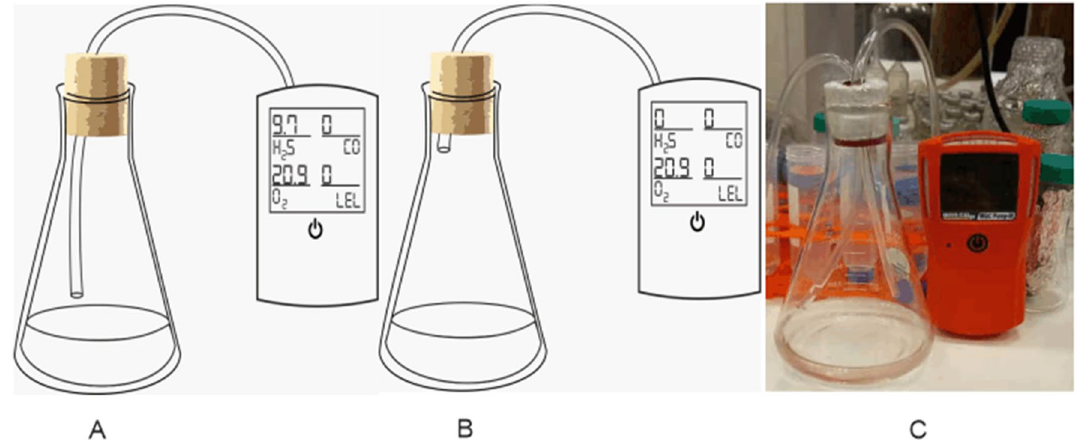
Figure 1. The assembled setup for H 2 S detection. ( A ) Schematics when the pipeline is in the bottom just near the liquid surface. ( B ) Schematic when the pipeline is at the top of flask. ( C ) The image of